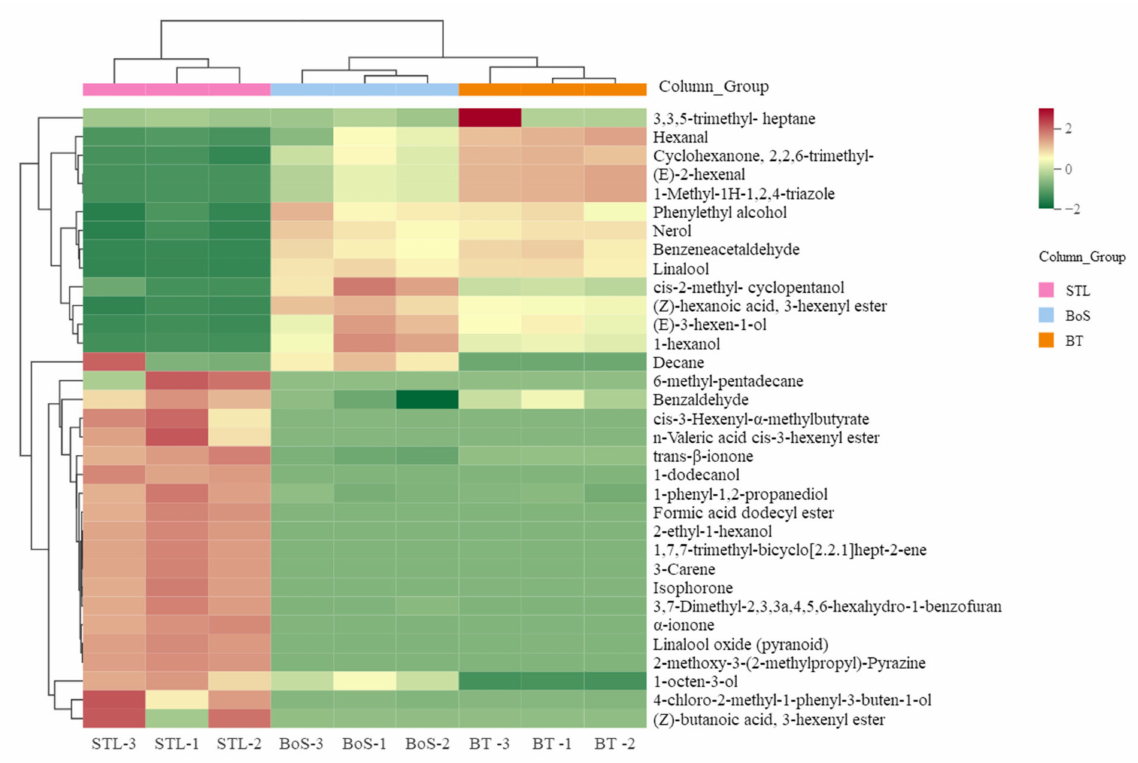
Figure 4. Component analysis showing the thermography of differential volatile metabolites in BT, STL, and BoS samples. STL, Strobilanthes tonkinensis Lindau; BT, black tea; BoS, black tea with added STL. Red represents high metabolite content, and green represents low metabolite